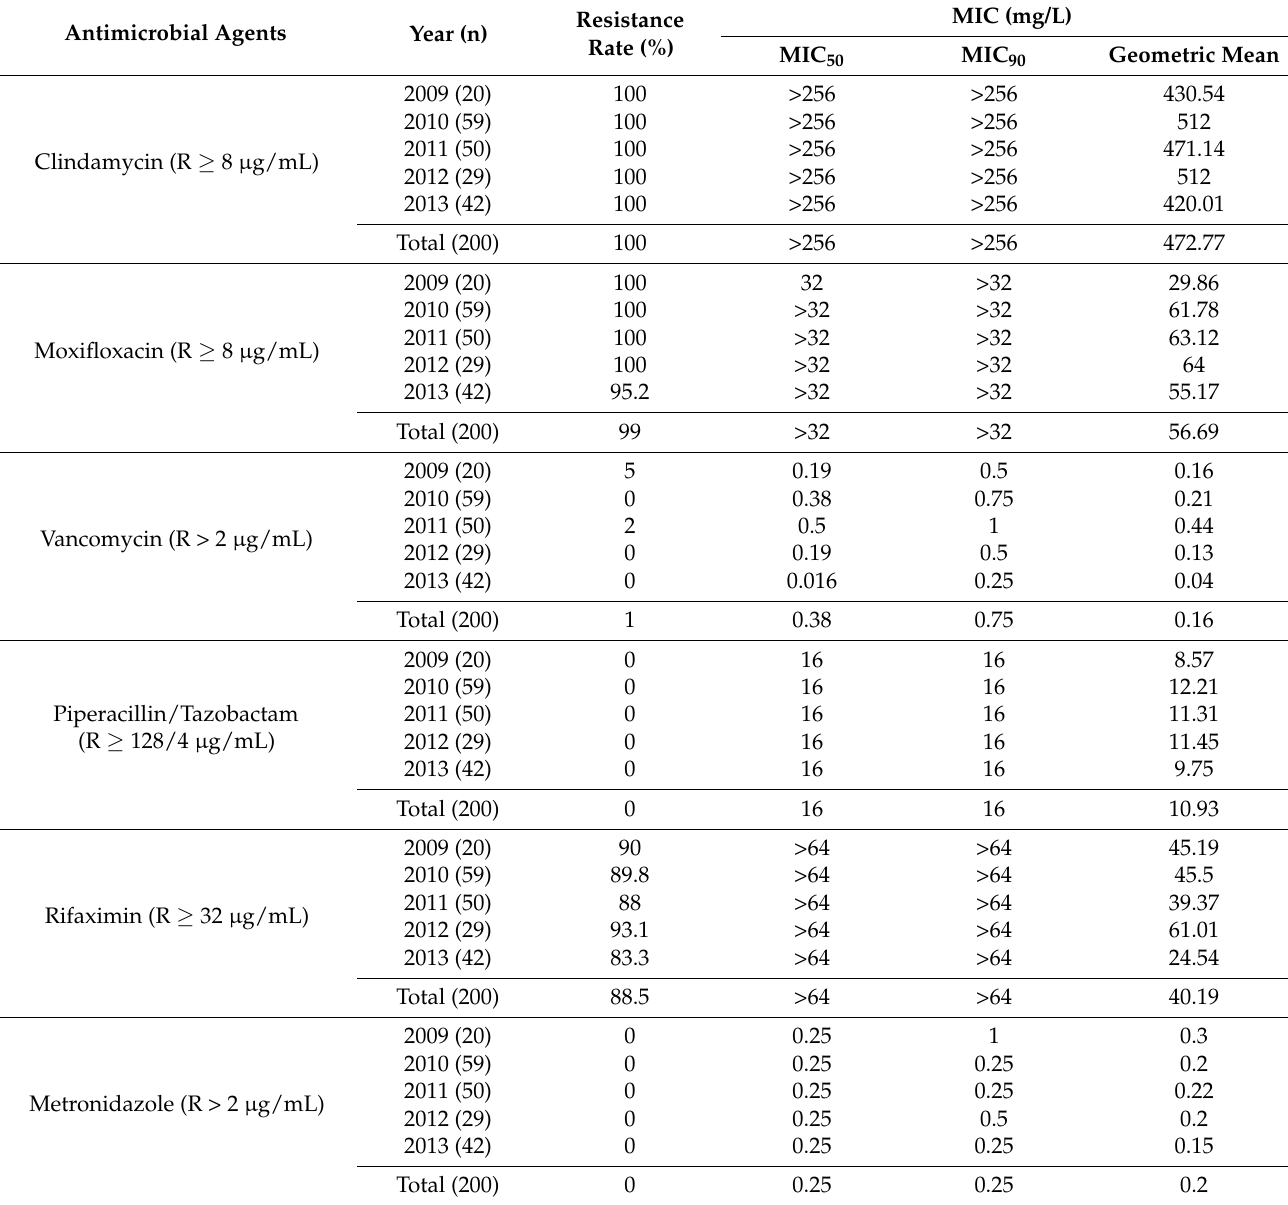
Table 1. Antimicrobial susceptibility tests of Clostridioides difficile polymerase chain reaction ribotype 017 strains by year. Antimicrobial